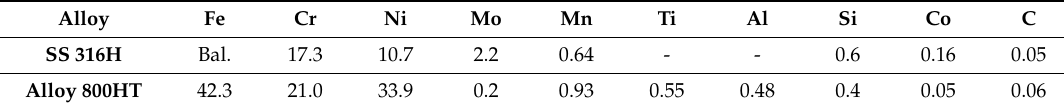
Table 1. Chemical compositions of the alloys used in this study analyzed by ICP (in wt.%).